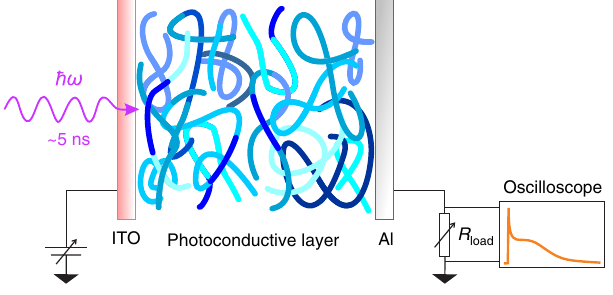
FIG. 16. Simplified schematic of the time-of-flight (TOF) photocurrent setup with a zoom-in of the TOF device structure. Concerning the photoconductive layer of the device, the varied blue shades across the spatially disordered polymer chains symbolize the presence of energetic disorder among charge- transport sites. For all relevant studies presented in this work, TOF devices were prepared by having ITO as the front ( “ trans- parent ” ) electrode and aluminium as the counter electrode. Figure components are not illustrated to